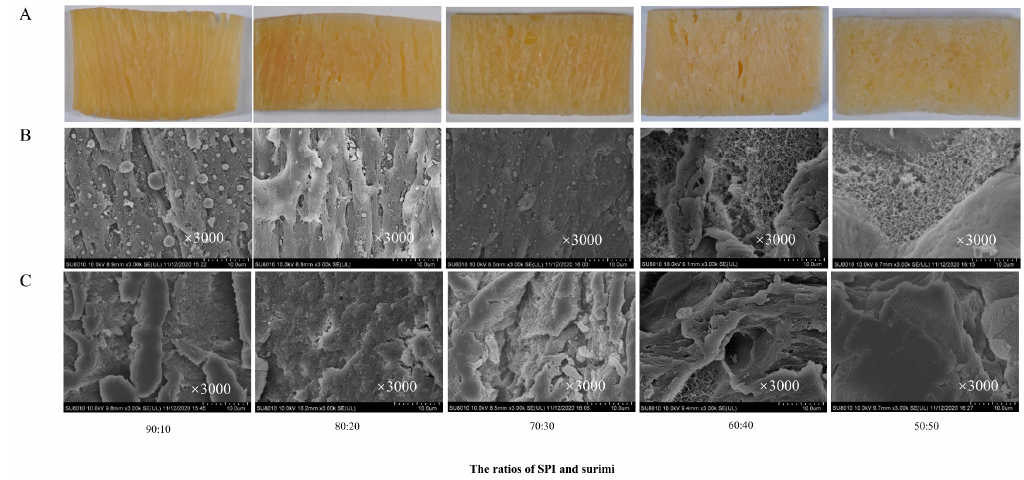
Figure 3. The macro- ( A ) and microstructure ( B , C ) of the extrudates of the SPI and surimi blends at different ratios along the extrusion direction ( A , B ) and perpendicular to the extrusion direction ( C ) .